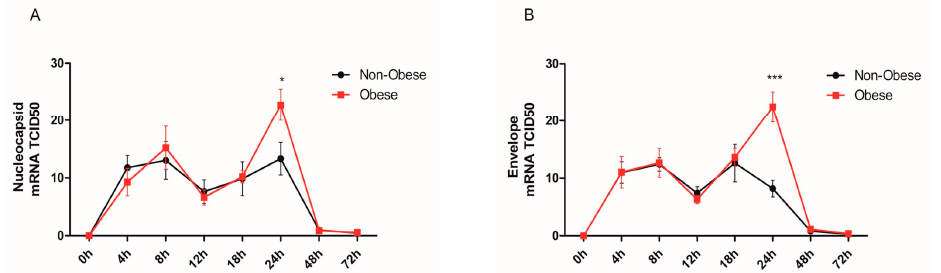
Figure 1. Increased SARS-CoV-2 replication in human bronchial epithelial cells (NHBE) from obese subjects. SARS-CoV-2 infection of bronchial epithelial cells (NHBE) with MOI 0.5. ( A ) Viral load was assessed by measuring nucleocapsid mRNA, n = 4/group; ( B ) replication was evaluated by measuring the SARS-CoV-2 envelope (UpE) gene, which was significantly higher in NHBE cells from obese subjects ( n = 4) compared to non-obese ( n = 4) subjects. One-way ANOVA test and Tukey post hoc, * p < 0.05; *** p < 0.001.